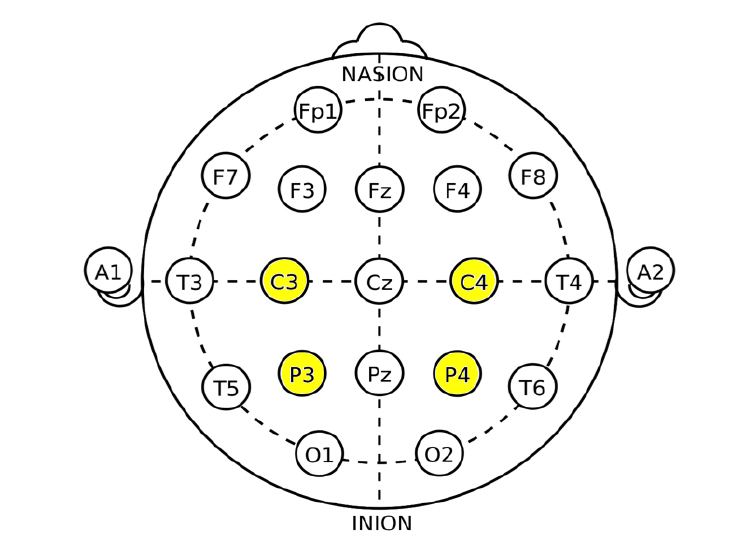
Figure 1. Location of the electrodes placed on